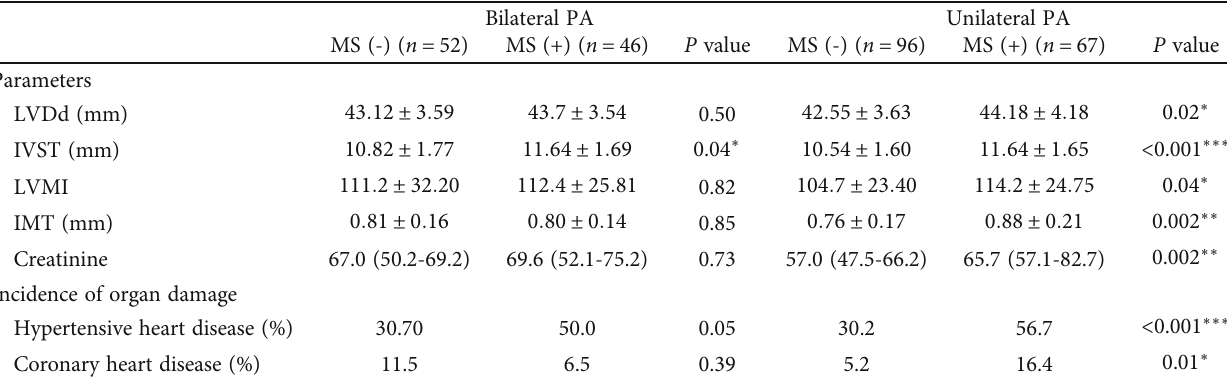
Table 4: Target organ damage in patients with bilateral and unilateral patients with or without